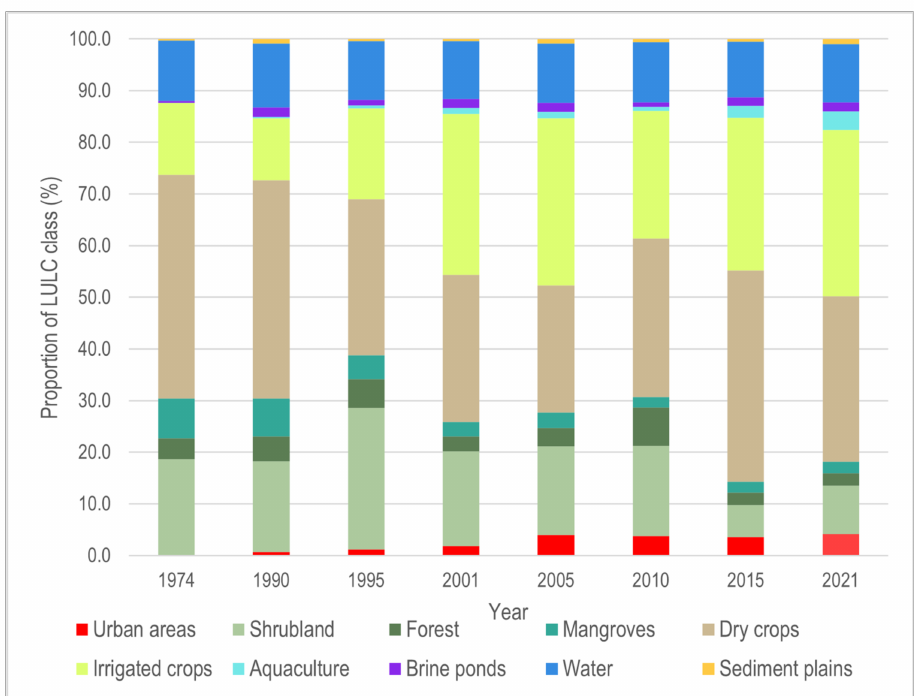
Figure 3. LULC compositions of the Ayeyarwady Delta from 1974 to 2021. Individual share of LULC classes can be obtained from the size of the 100% proportion (individual class